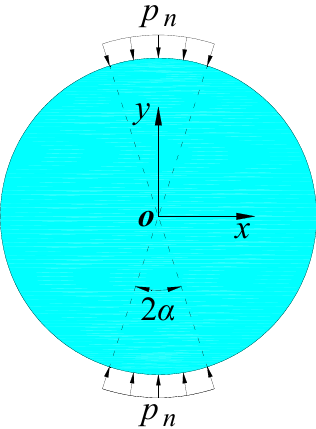
Figure 2. The axial compression on the part boundary of the circular shaft.